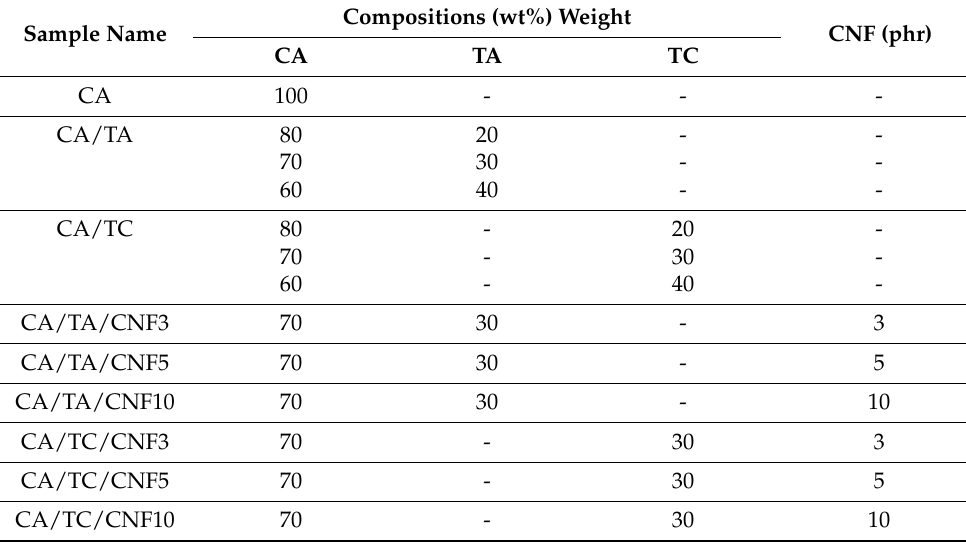
Table 1. Sample compositions (applied to both acetone and NMP solvents).